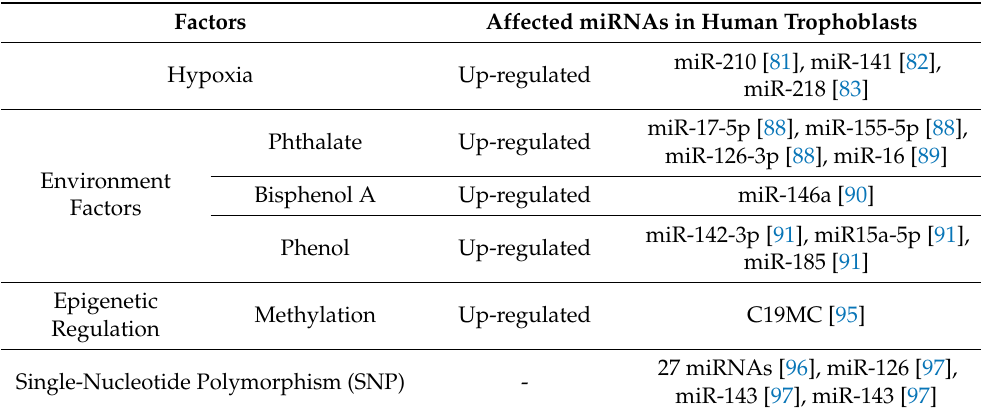
Table 1. Summary of factors that affect expression of miRNAs in human